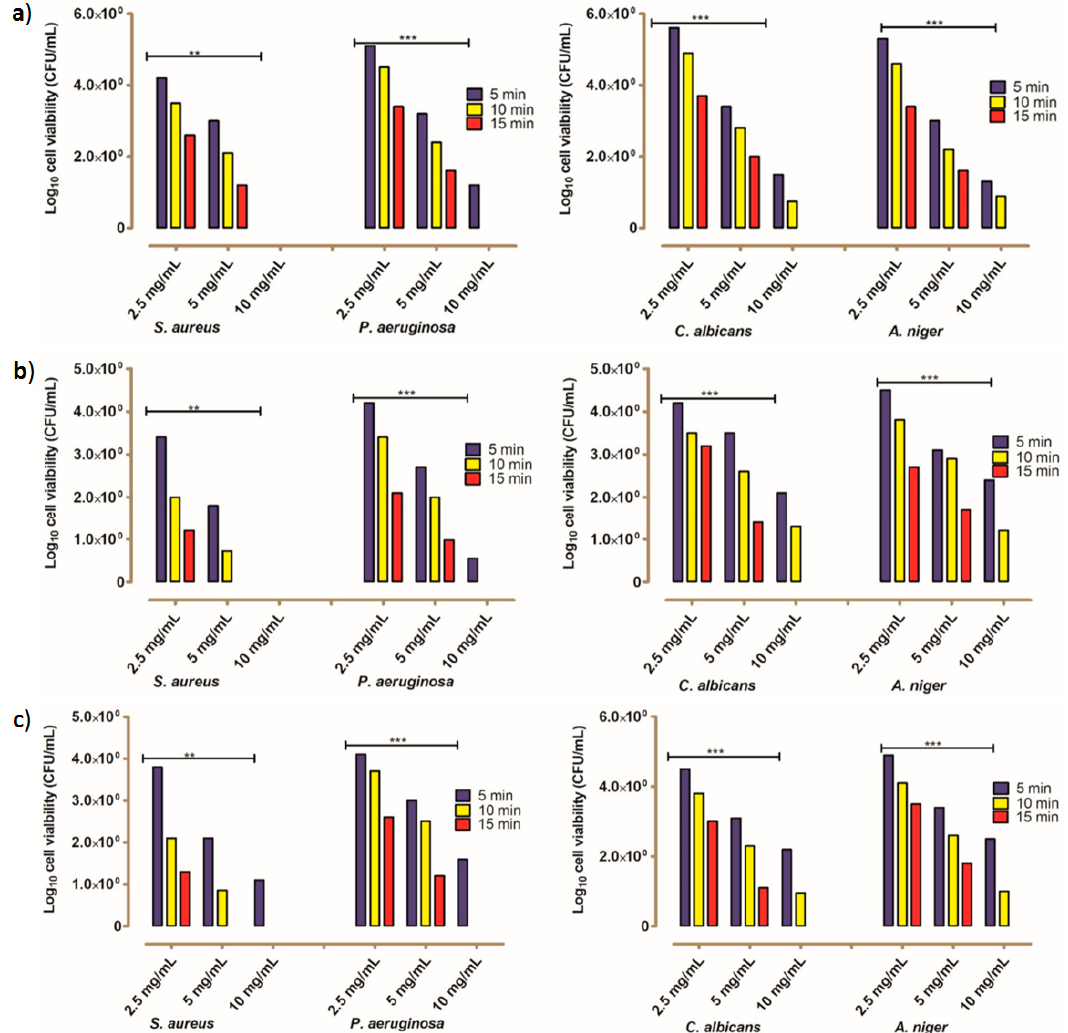
Figure 3. Minimum inhibitory concentration values of the tested compounds ( a ) 9, ( b ) 10, and ( c ) 11 towards targeted microbes. The remained viable cell populations at various time intervals of 5, 10, and 15 min, are also shown. Two-way analysis of variance ( ANOVA ) states * indicates low correlation ( p ≤ 0.05), ** indicates moderate correlation ( p ≤ 0.01), *** indicates high correlation ( p ≤ 0.001). Table 2. Summaries of the estimated values of minimum inhibitory concentration (MIC) for the tested compounds towards targeted microbes.